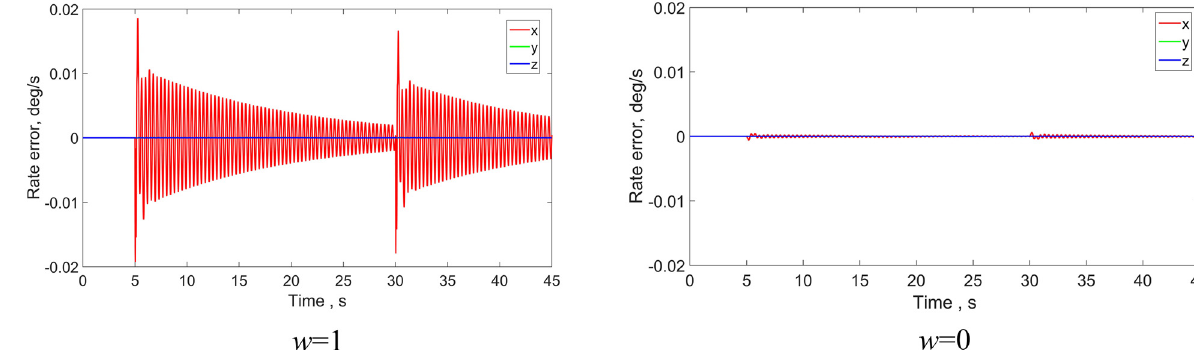
Figure 28: Rate attitude errors for case 3.